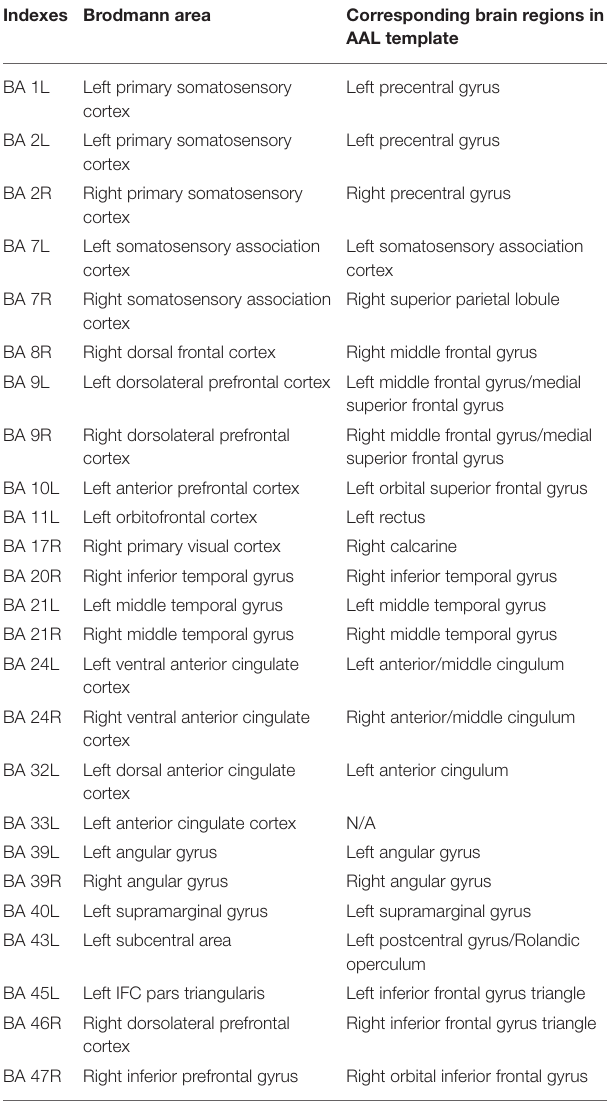
TABLE 2 | Indexes and corresponding brain